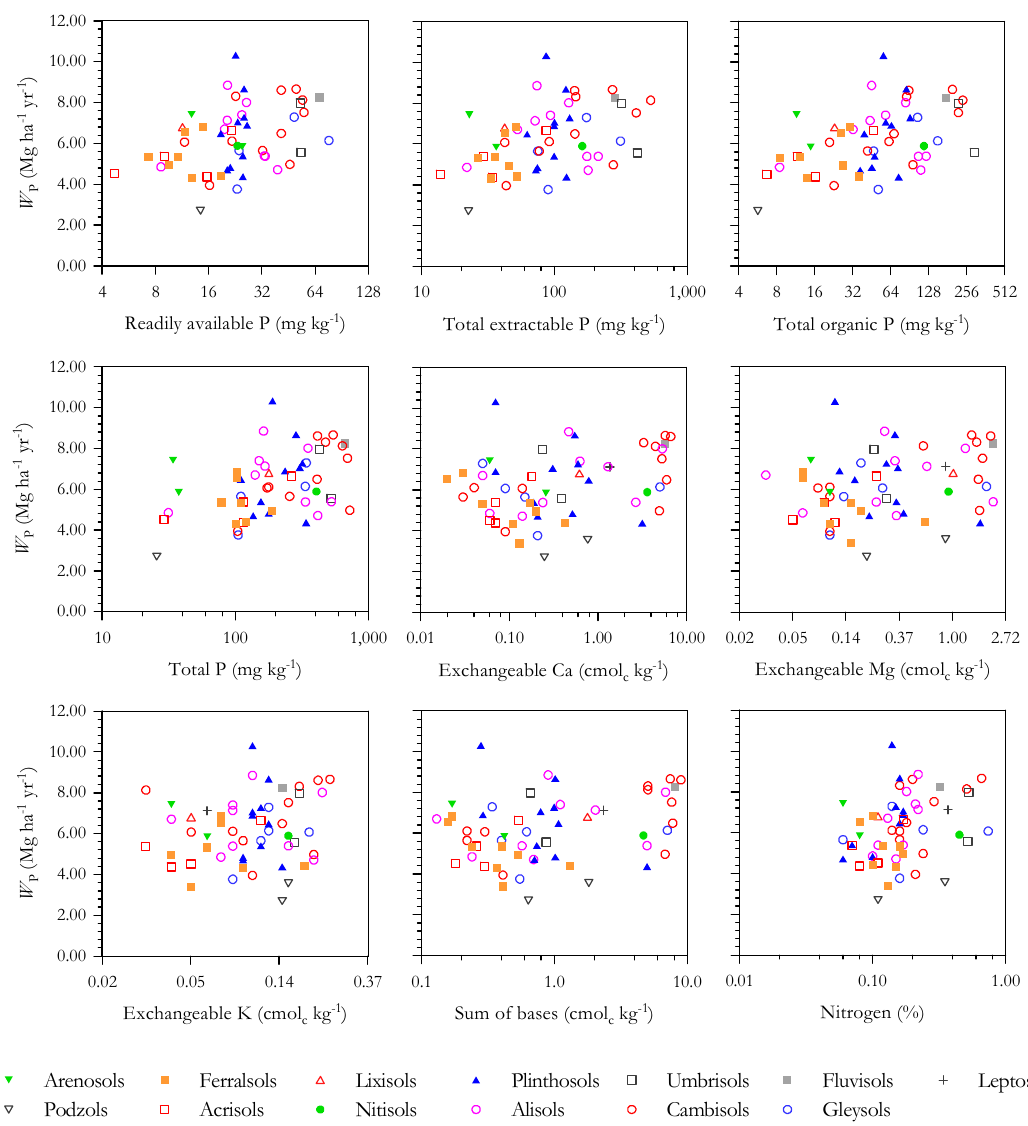
Fig. 3. Relationships between above-ground coarse wood production ( W P ) and different soil nutrient